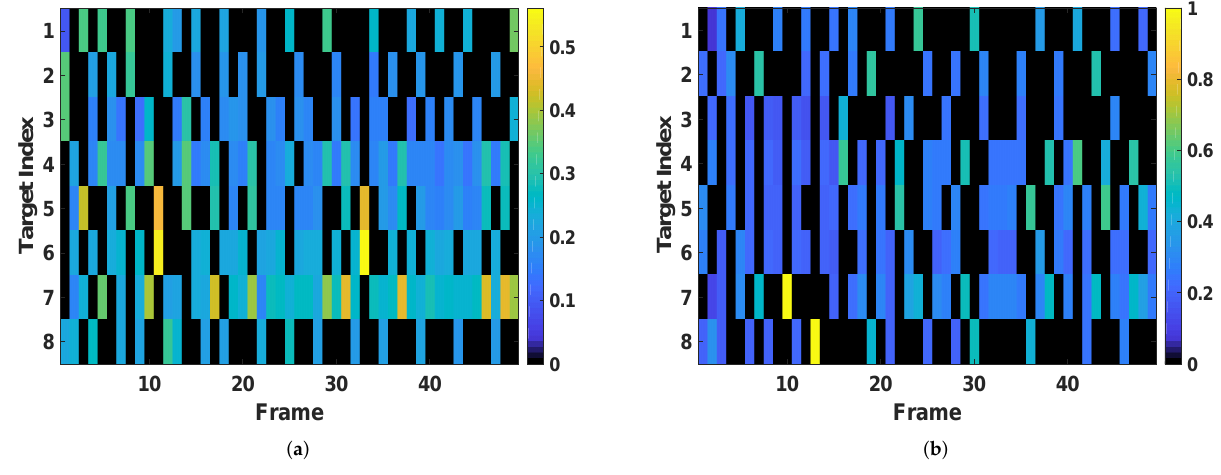
Figure 7. The simultaneous multibeam power allocation results. ( a ) Proposed power allocation method. ( b ) Optimization-based power allocation